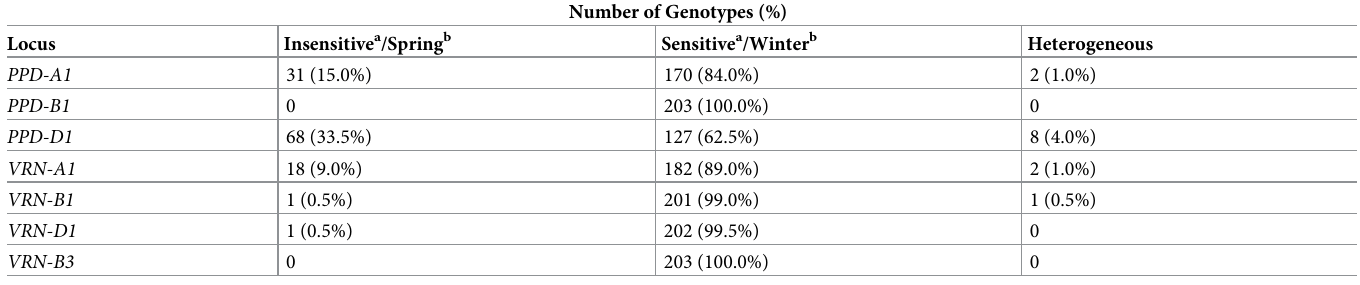
Table 2. Frequency of genotypes with different photoperiod and vernalization alleles at the major loci for 203 genotypes in the diversity panel. Number of Genotypes